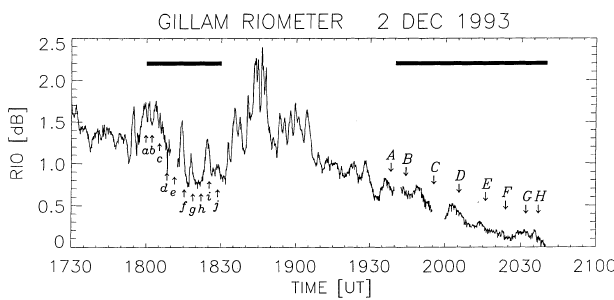
Fig. 7. The riometer absorption at Gillam. The horizontal bars indicate two pulsation periods discussed in the text. The arrows indicate the times of the overhead passages of the BARS backscatter bands trailing the absorption enhancements as they drifted poleward over